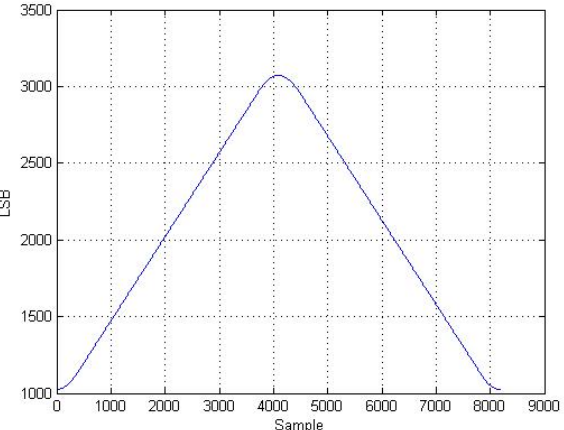
Figure 5. Modulating wave, digitally generated with smoothed edges to not exciting fiber stretcher